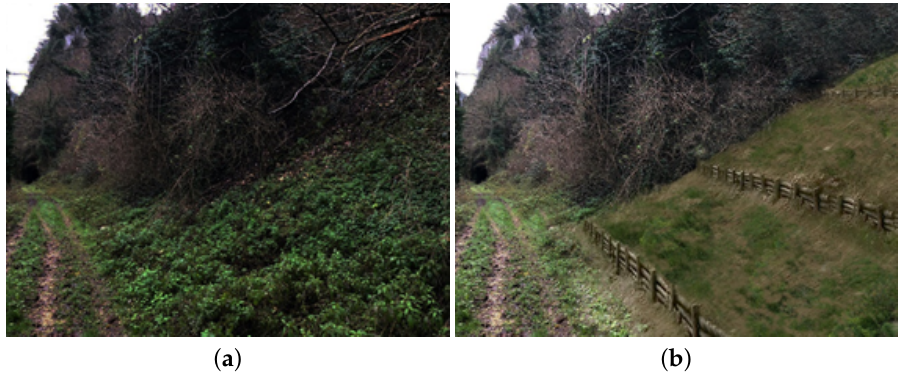
Figure 10. Simulated naturalistic work for S2 through photographic rendering: ( a ) initial condition of the slope; ( b ) condition after naturalistic work